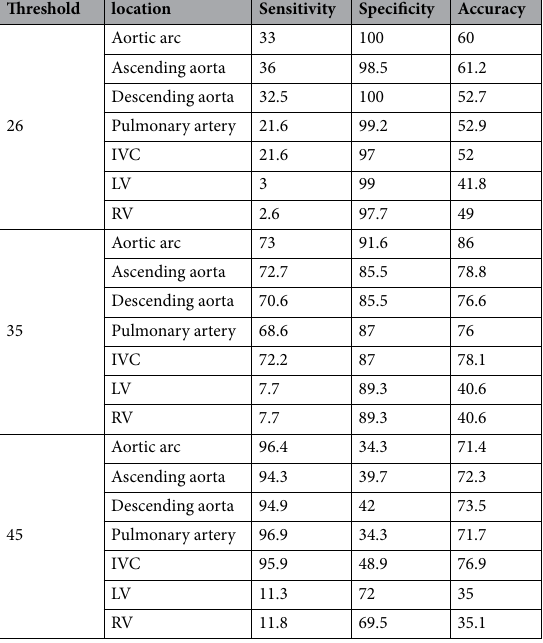
Table 4. Sensitivity, specificity, and accuracy for diagnosis of anemia at various threshold values of blood CT attenuation in different anatomic locations. RV right ventricle, LV left ventricle.